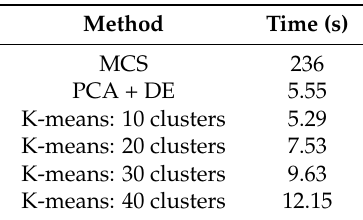
Table 5. Comparison of computation time of different